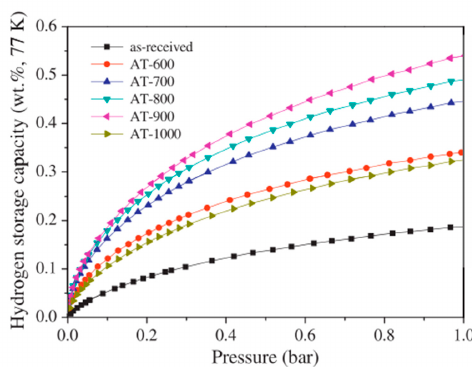
Figure 3. The hydrogen storage capacity of the KOH-activated MWCNTs at different activation temperatures (600 °C , 700 °C, 800 °C, 900 °C, 1000 °C), the weight ratio of KOH:MWCNT = 4:1 [105] . Nanomaterials 2020 , 10 , 255